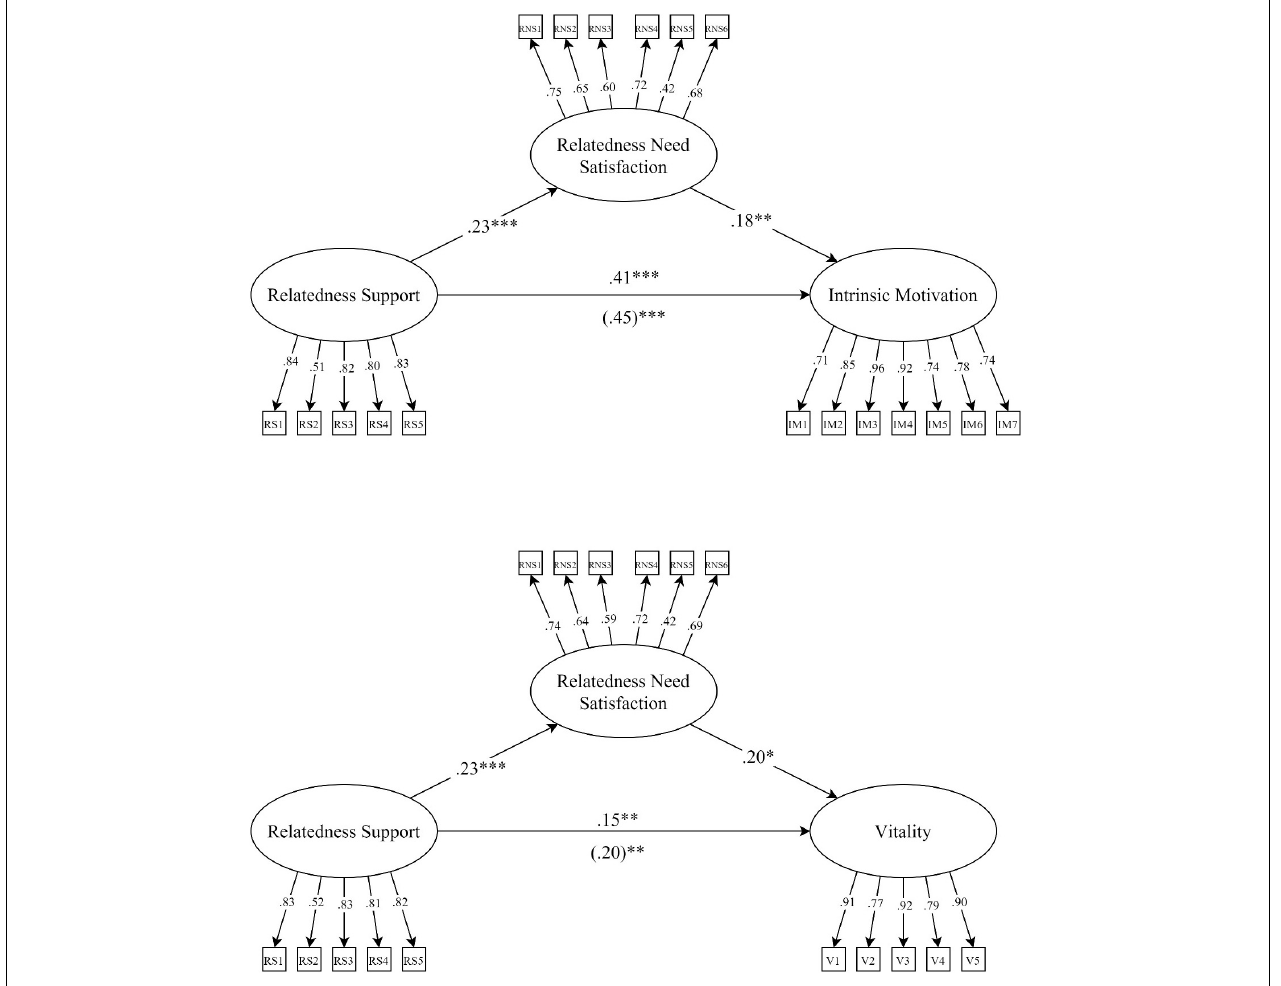
FIGURE 2 | The mediating role of relatedness satisfaction between perceived relatedness support and intrinsic motivation/vitality with standardized coefficients. The numbers in parentheses represent the total effect. ∗ p ≤ 0.05, ∗∗ p ≤ 0.01, ∗∗∗ p ≤